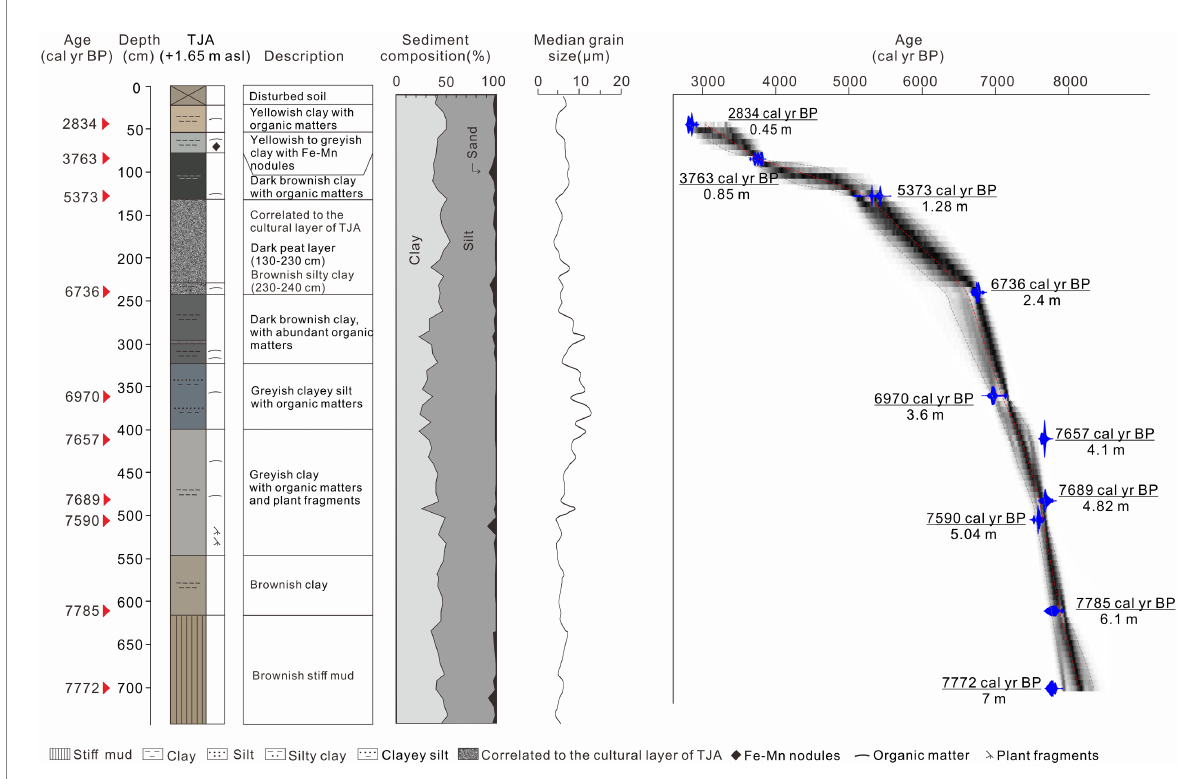
FIGURE 2 Sediment lithology, grain-size distributions, and age model of core